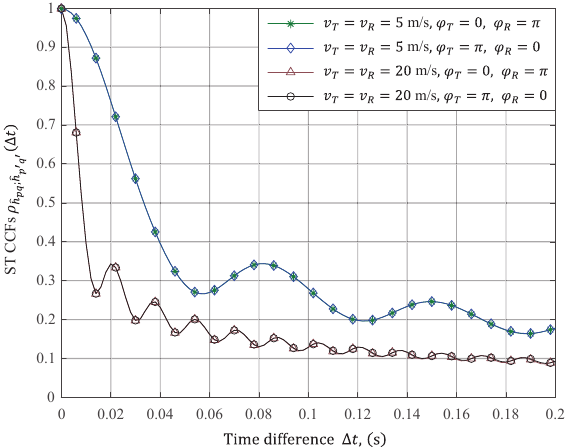
( ∆ t ) of WSSUS MIMO V2V channel models with respect to the Figure 7. Estimated ST CCFs ρ ˆ h pq ˆ h p (cid:48) q (cid:48) moving directions/velocities of the MT and MR when Ω = 0 and D 0 = 100 m.